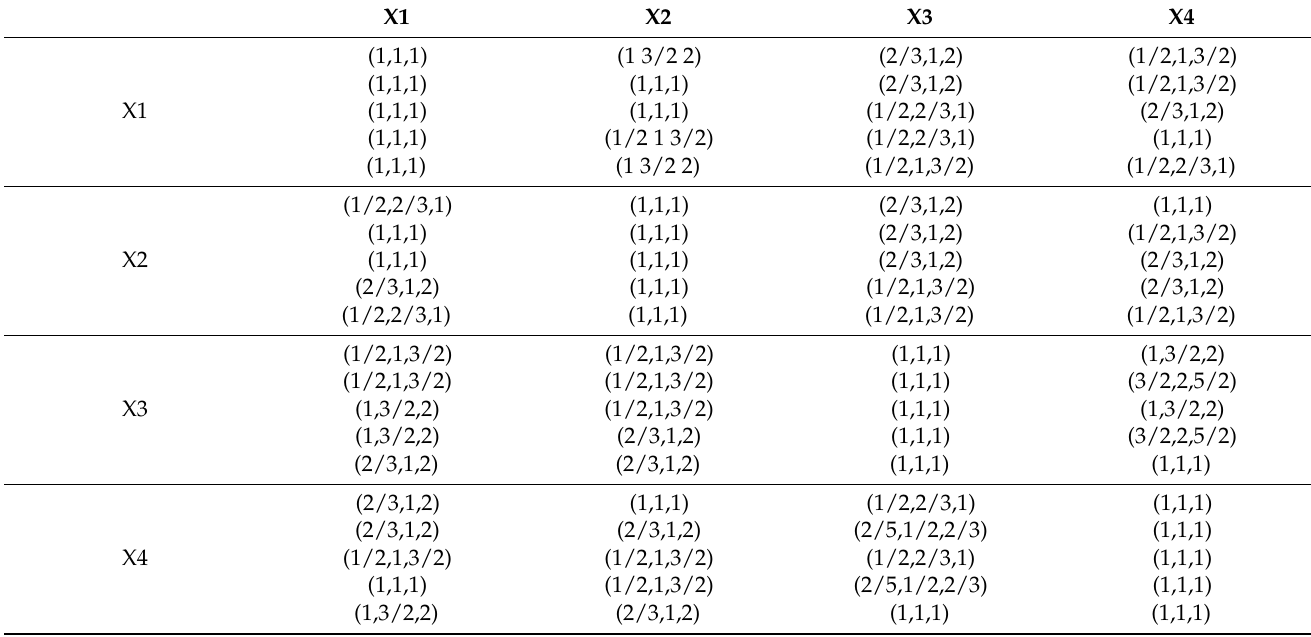
Table A2. Pairwise comparison of the elements in the category of ‘Errors’.